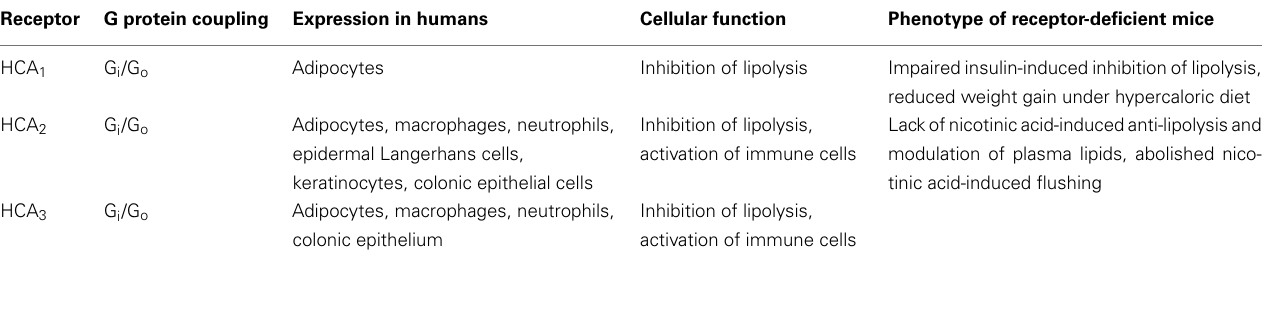
Table 2 | Pharmacological and biological properties of HCA